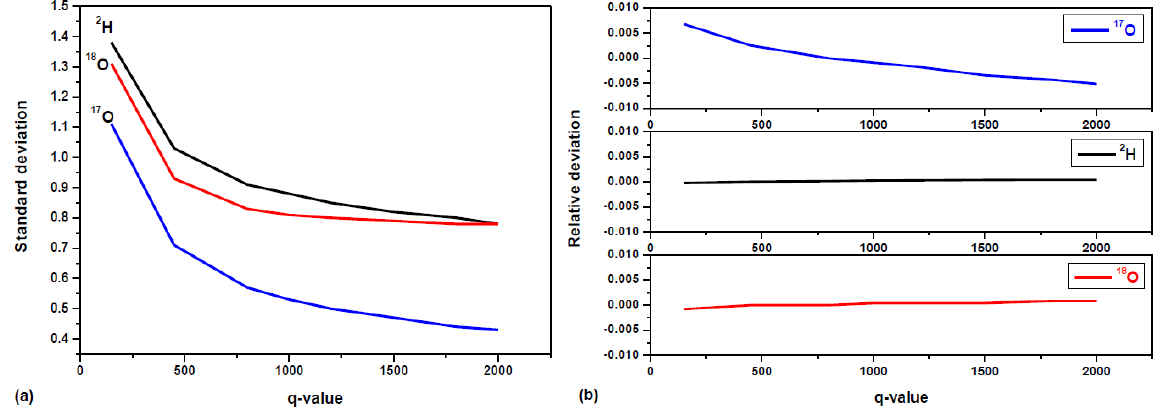
Figure 7. ( a ) Plots of the standard deviation in water (Vittel) isotope ratio determination water (GS-42) isotope ratio measurement accuracy, ( ) /    , plotted in function of the